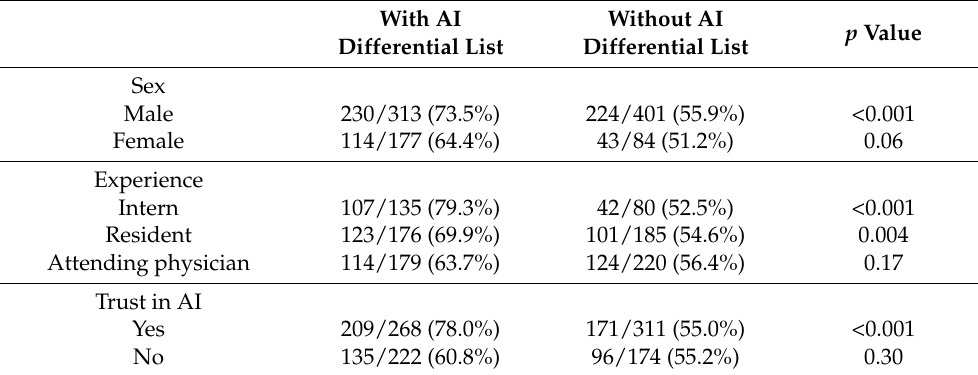
Table 3. Prevalence of physician diagnosis identical with the differential diagnosis of AI in the